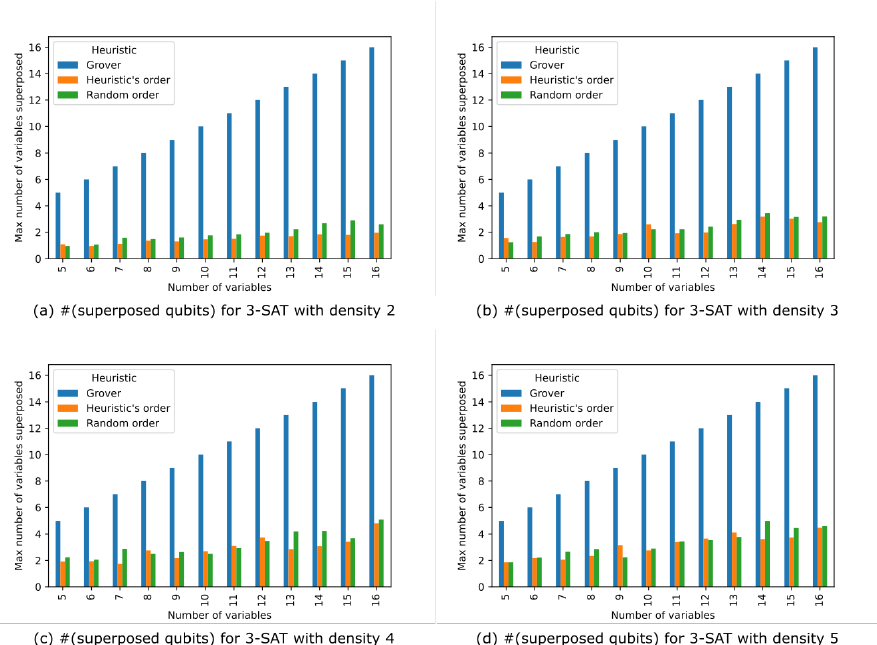
Figure 4. Comparisons of number of superposed qubits for 3-SAT formulas according to densities.